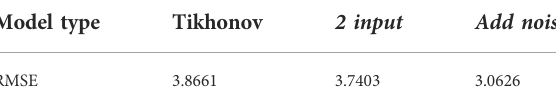
TABLE 4 RMSE index comparison after the continuation of measured data in three different methods. Model